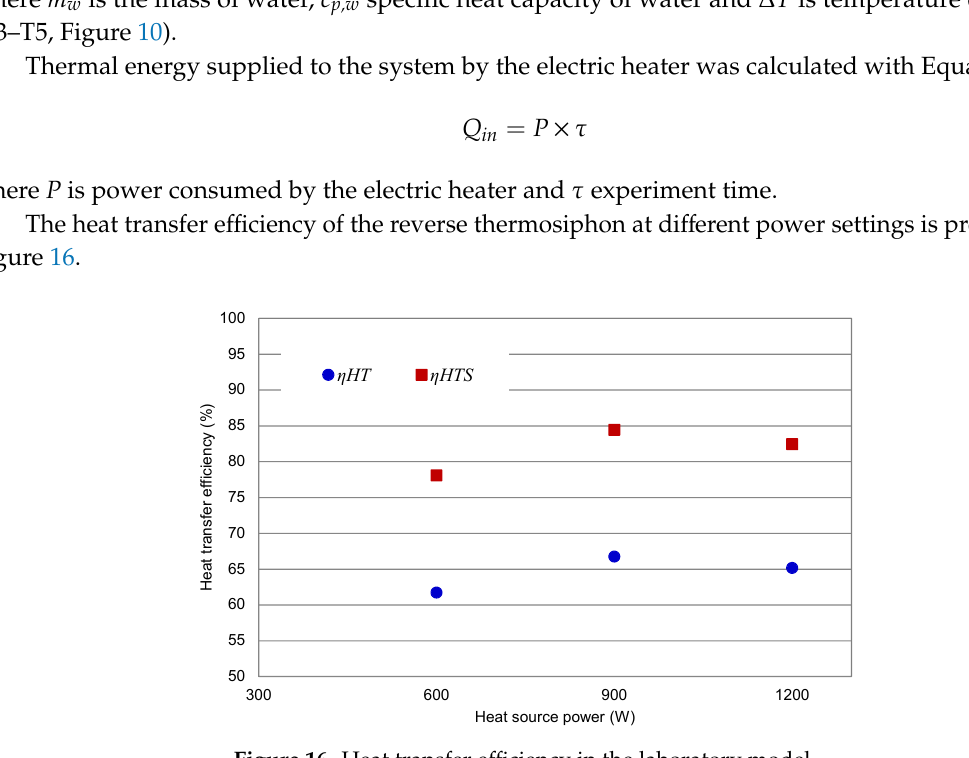
Figure 16. Heat transfer efficiency in the laboratory model.